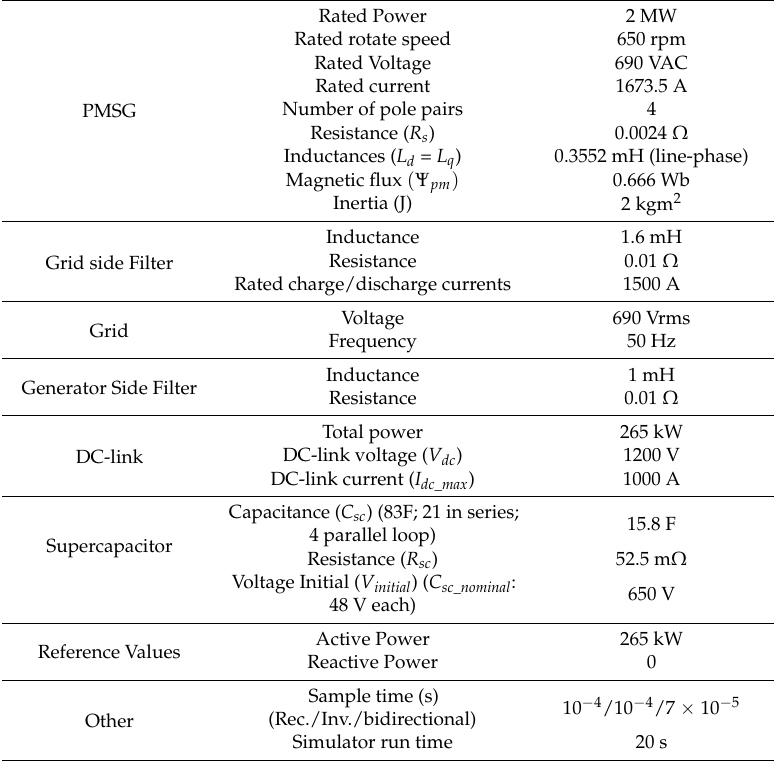
Table A1. System parameters used in the